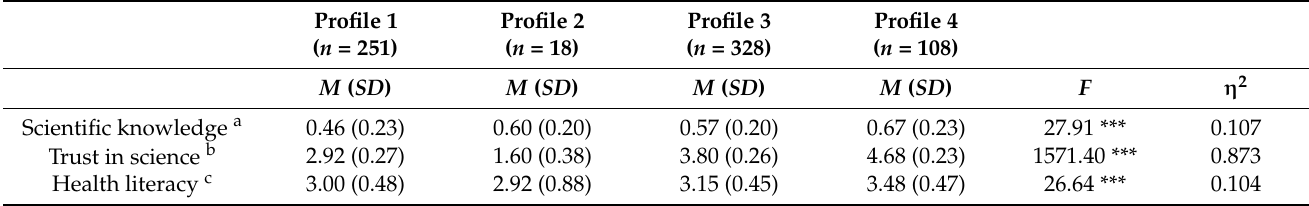
Table 3. General scientific knowledge, trust in science, and health literacy: profile means.